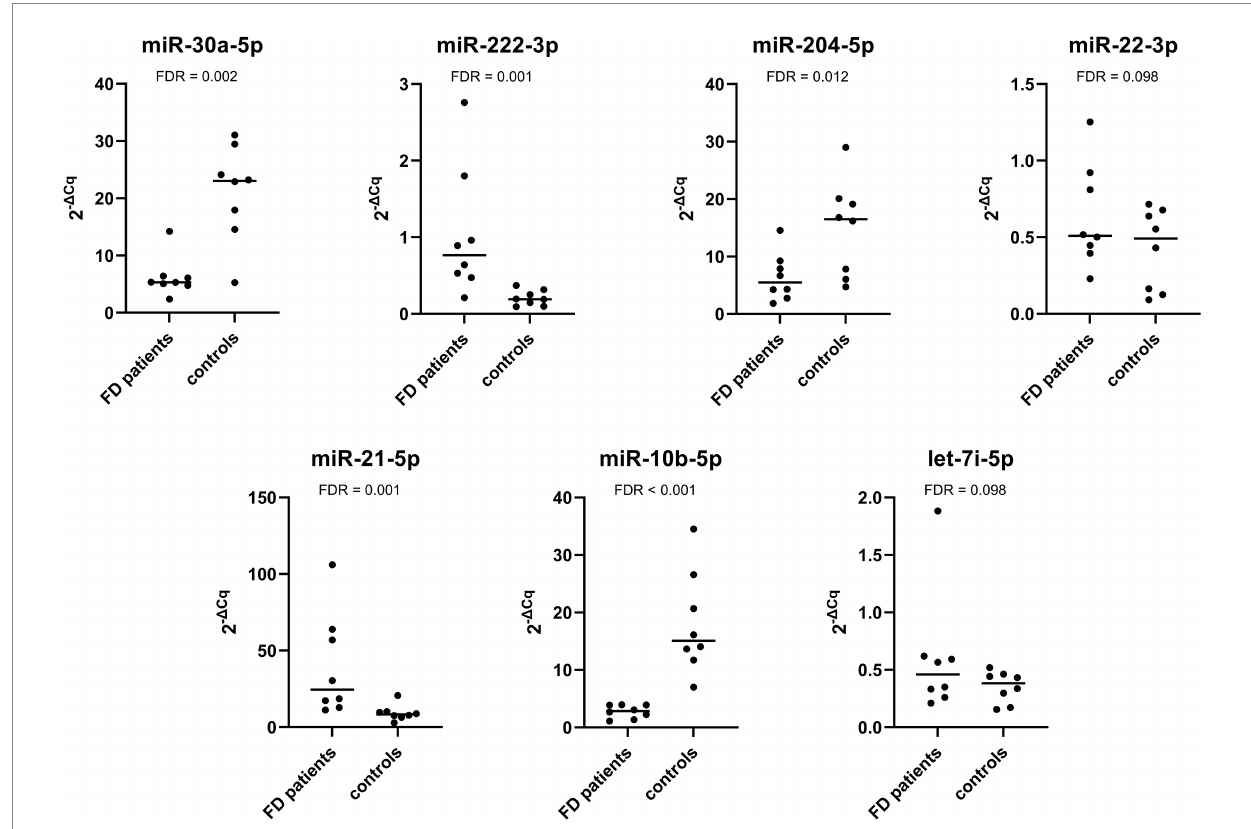
FIGURE 3 Relative expression of selected miRNAs in the validation cohort composed of Fabry patients with progressive nephropathy and their matched